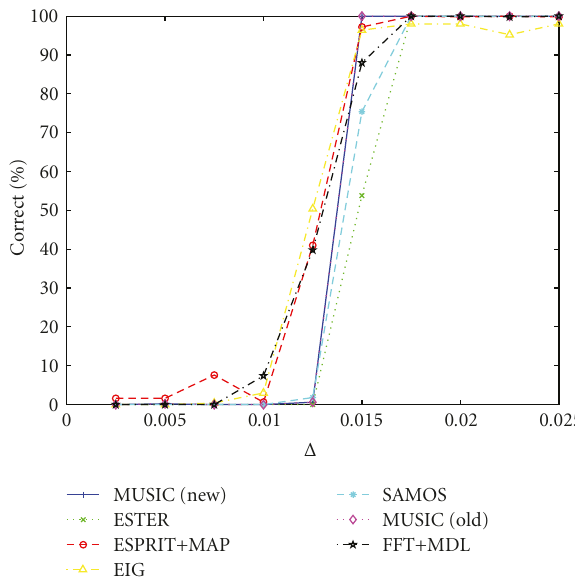
Figure 6: Percentage of correctly estimated model orders as a func- tion of the di ff erence between frequencies distributed uniformly as 2 π Δ l with SNR = 20 dB and N =